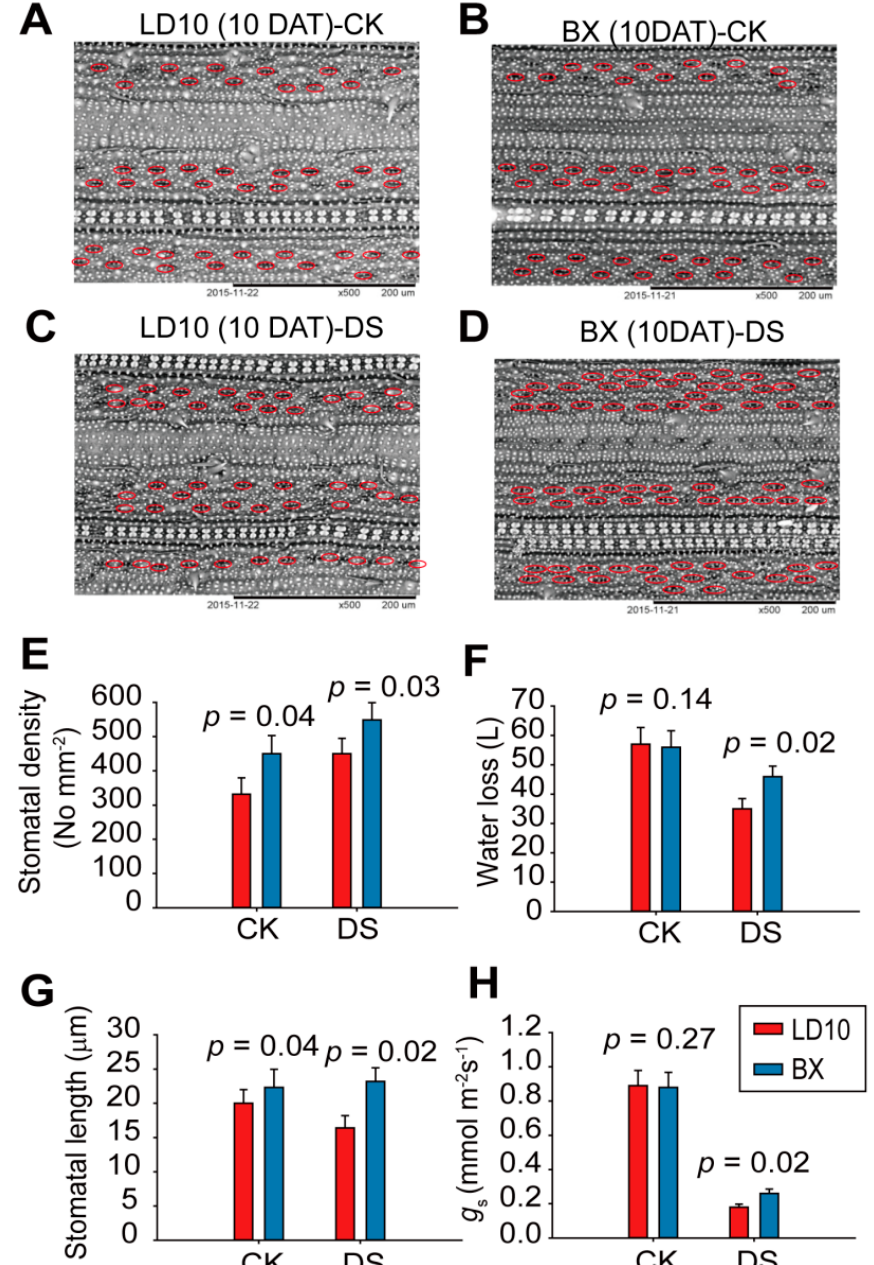
Figure 3. The changes in stomatal profilings between LD10 and BX exposed to drought treatments after 10 days. ( A – D ) Epidermis images of LD10 and BX after 10 days of treatment under control ( A , B ) and DS conditions ( C , D ). Red circles were used to label the stomatal apertures. ( E , F ) Stomatal density and stomata length of the two rice accessions with or without drought treatments. Values represent mean ± standard deviation ( n = 30). ( G , H ) Water loss per plant and leaf stomatal conductances of two rice accessions exposed to drought treatments. Values represent mean ± standard deviation ( n = 6). Student’s t -test was used to represent the significant levels, where different letters stand for significant levels at p <